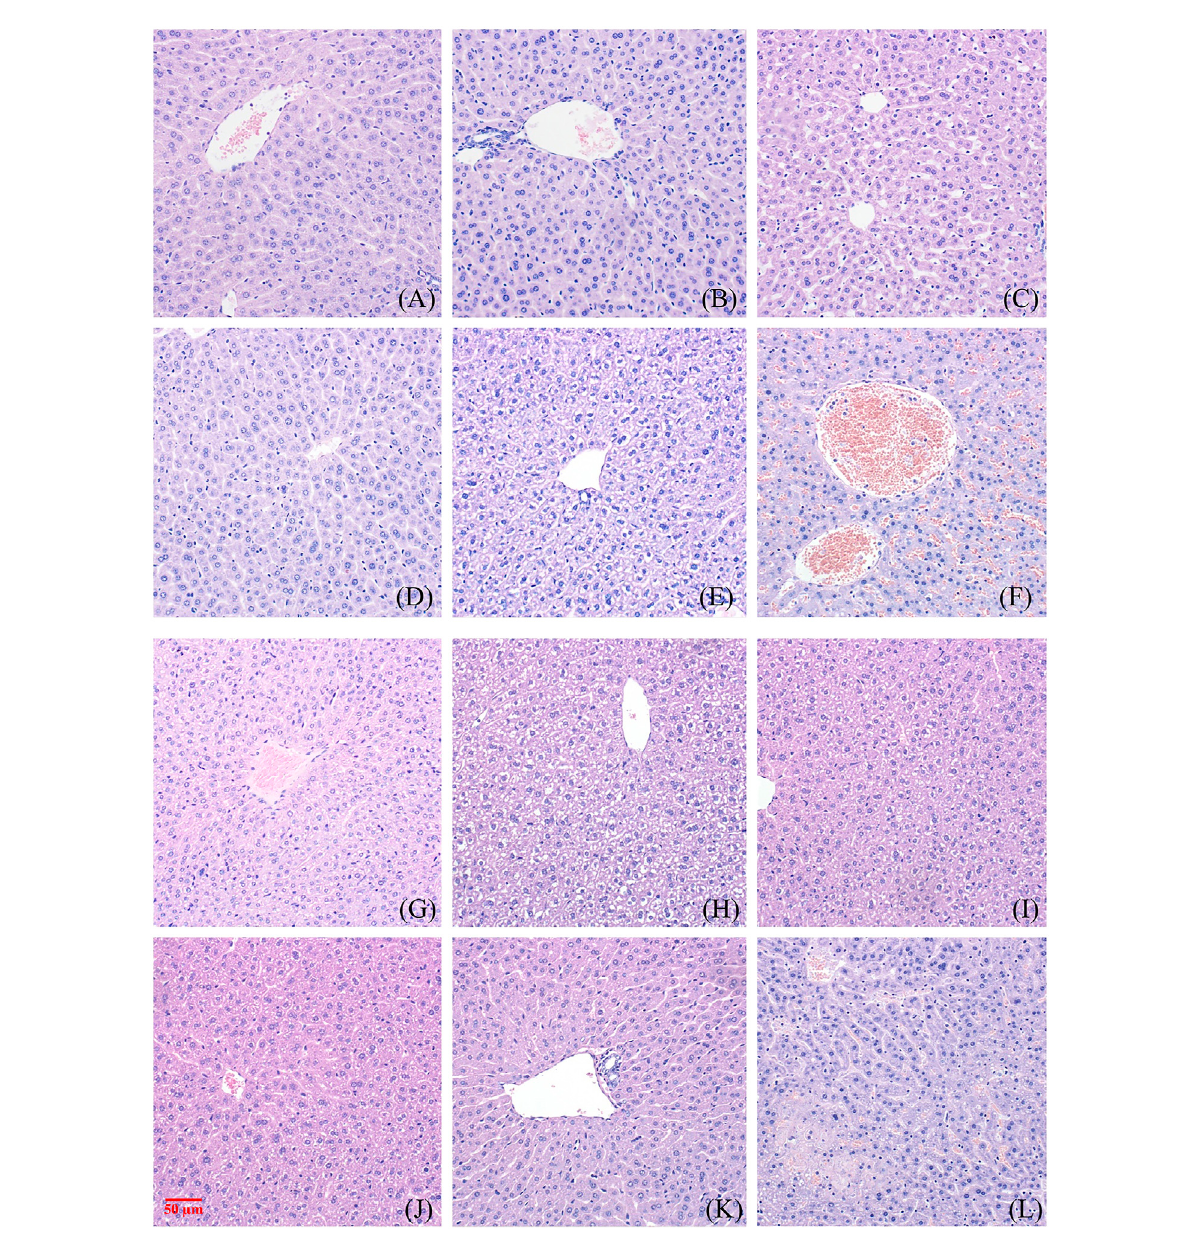
FIGURE 3 ToxiceffectofdifferentdosesofNAYonlivertissueofmice.( (A – F) malemiceand (G – L) femalemice).[ (A) 0 mg/kg; (B) NAY50 mg/kg; (C)